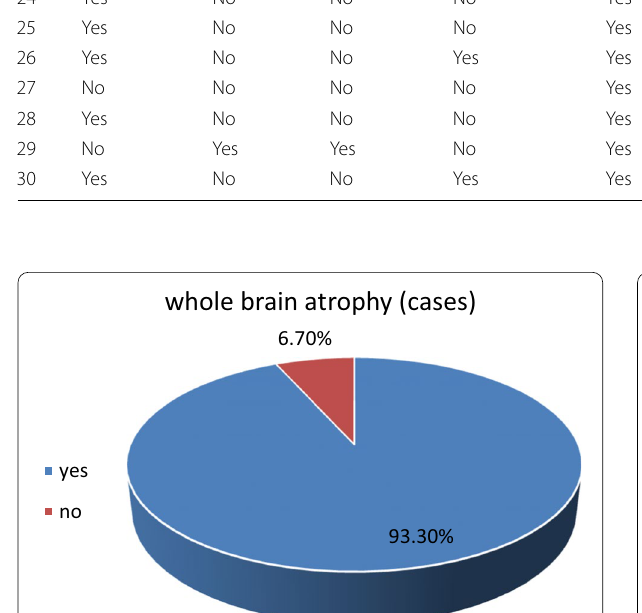
Fig. 4 Diagrammatic representation of percent of patients with thalamic